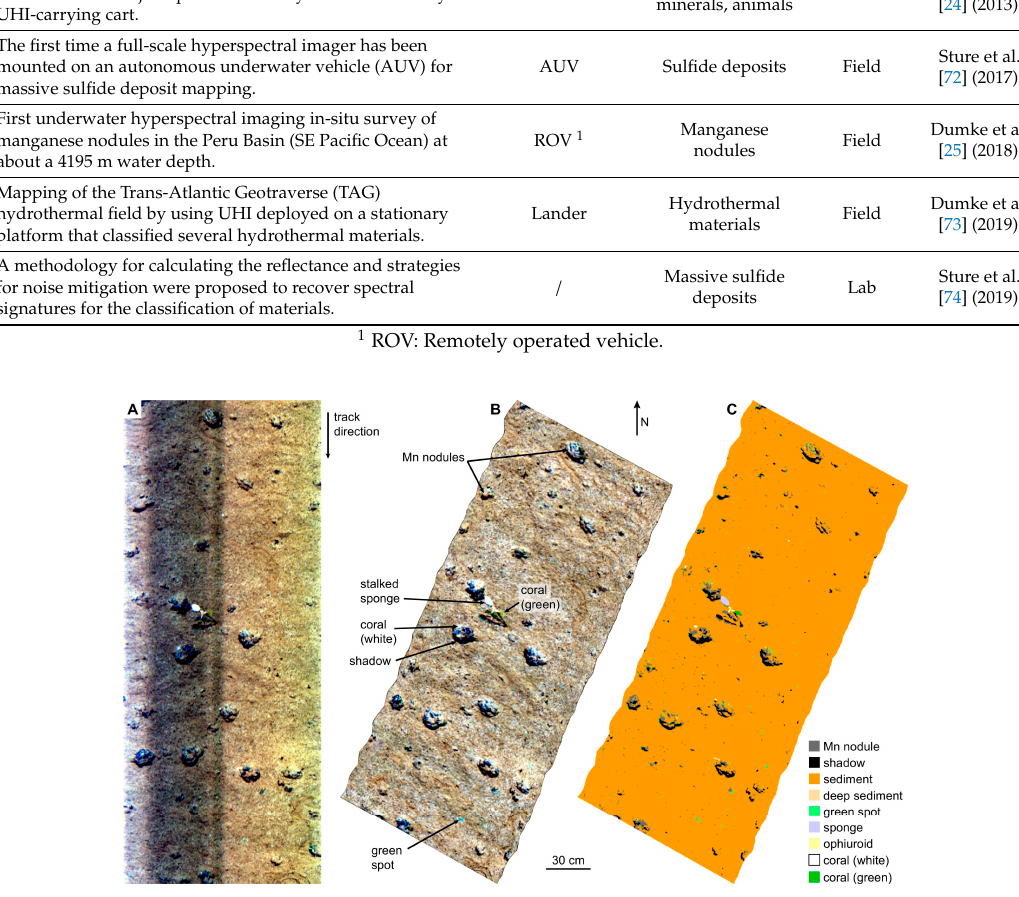
Figure 3. Left to right: ( A ) UHI radiance data in Red-Green-Blue (RGB) (R: 645 nm, G: 571 nm, B: 473 nm); ( B ) geocorrected pseudo-reflectance data in pseudo-RGB, and ( C ) support vector machine (SVM) classification image based on the data in ( B ). Dumke et al. [25]. Copyright (2020), with permission from Elsevier.